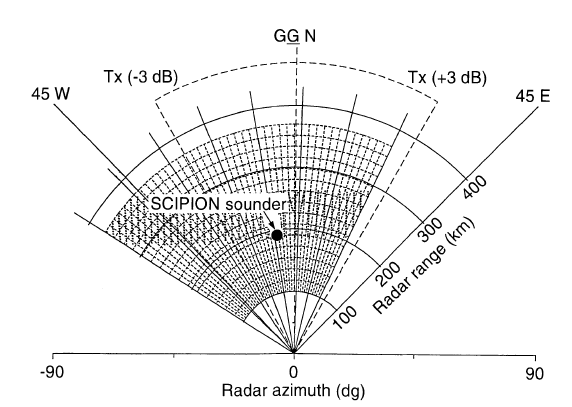
Fig. 1. The experiment performed with the radar of Valensole looking northwards. The ionospheric sounder SCIPION was located 150 km north of the radar ( (cid:24) 190-km radar range at 110-km altitude) in azimuth 10 (cid:176) W. The receiving antenna pattern includes 42 elementary beams each having a 2 (cid:176) beamwidth. Also shown are the 15 radar ranges, from 100 to 352 km, and the best magnetic aspect angle region ( dotted area ) for aspect sensitive backscatter at E-region altitudes between 90 and